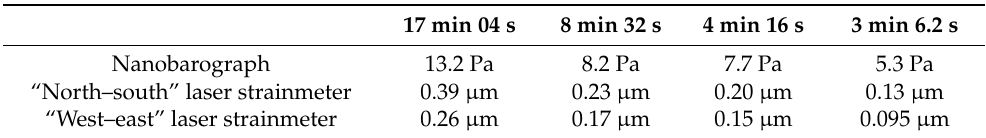
Table 1. Data of spectral processing of records of the laser-interference systems, installed at Schulz Cape, the first direct passage of Lamb waves near Schultz Cape.